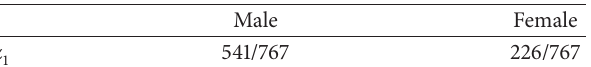
Table 2: Gender univariate 𝛼 1